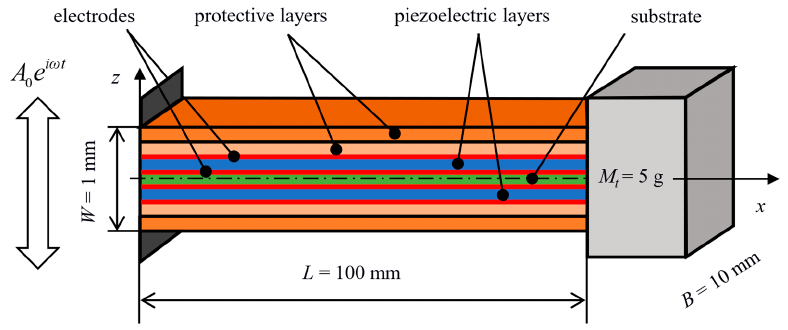
Figure 2. The considered multilayer piezoelectric harvester.